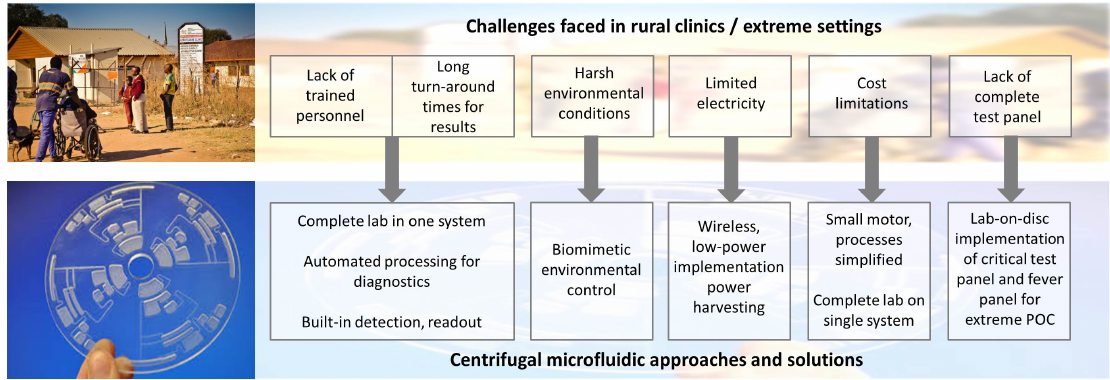
Figure 1. Overview of topics discussed in this paper, including the challenges faced in rural clinics and corresponding CD-based technologies for addressing these